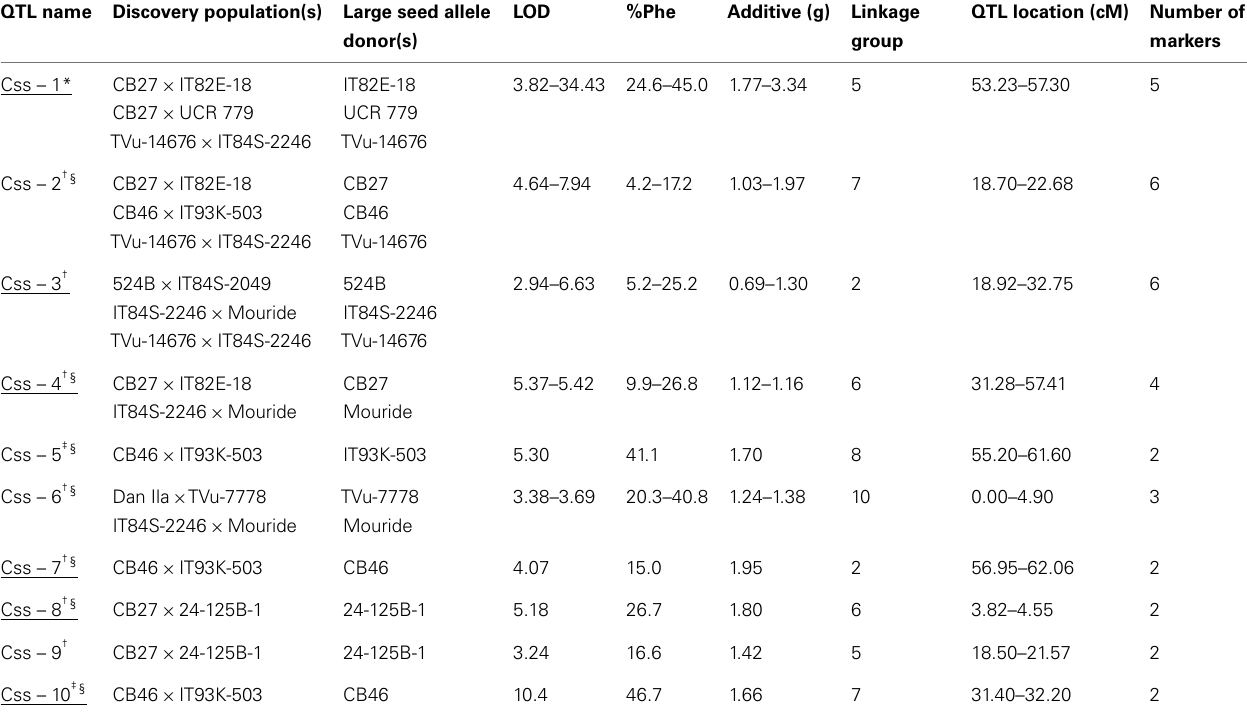
Table 2 |Ten seed size QTL identified among eight bi-parental populations of